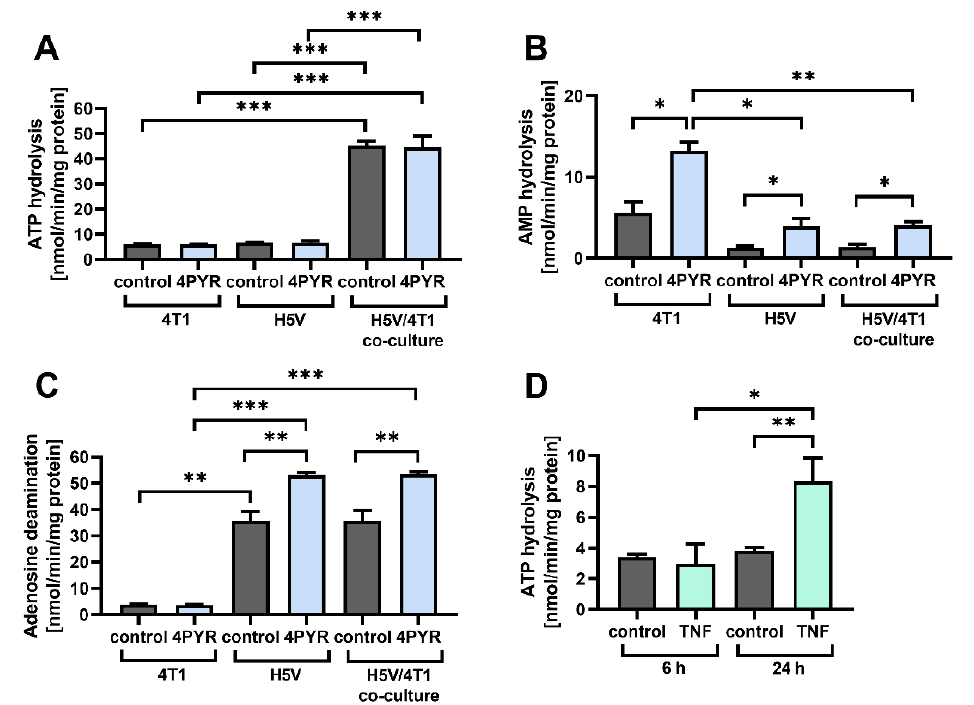
Figure 4. 4PYR regulates eAdo generation and deamination during paracrine interactions between 4T1 and H5V endothelial cells. ( A – C ) Effect of 4PYR (100 µ M) on the rate of extracellular ATP hydrolysis ( A ), AMP hydrolysis ( B ), and adenosine deamination ( C ) in the co-culture of H5V and 4T1 cells, compared to single-cell type cultures. Vehicle-treated cells were used as a control. Cells were separated using a filter (pore size of 1 µ m) in a Transwell chamber. 4PYR was added to the upper chamber containing 4T1 cells. Enzymatic activity was measured via reversed-phase HPLC after 72 h of culture. ( D ) Effect of TNF (10 ng/mL) on the rate of eATP hydrolysis by H5V cells. Enzymatic activity was measured on 96-well plates via reversed-phase HPLC after 6 or 24 h of culture. Vehicle-treated cells were used as a control. Graphs represent the mean ± SEM from four independent experiments. * p < 0.05, ** p < 0.01, *** p < 0.001.